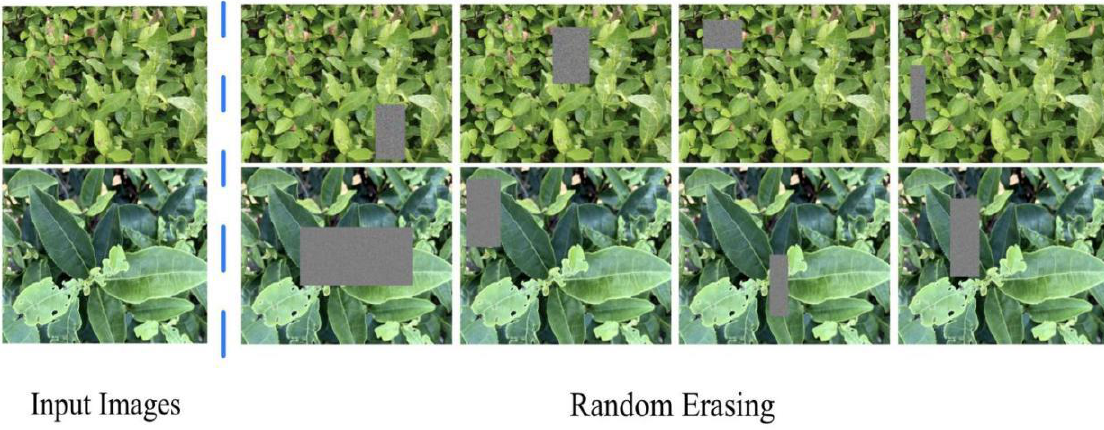
Figure 3. Random Erasing data enhancement effect diagram.